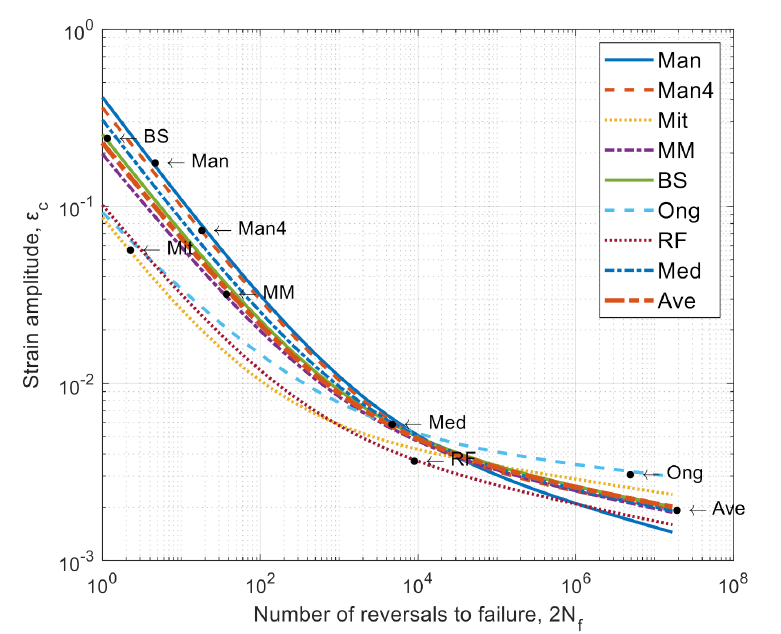
Figure 7. Summary of Manson-Coffin-Basquin curves for determined fatigue material models.